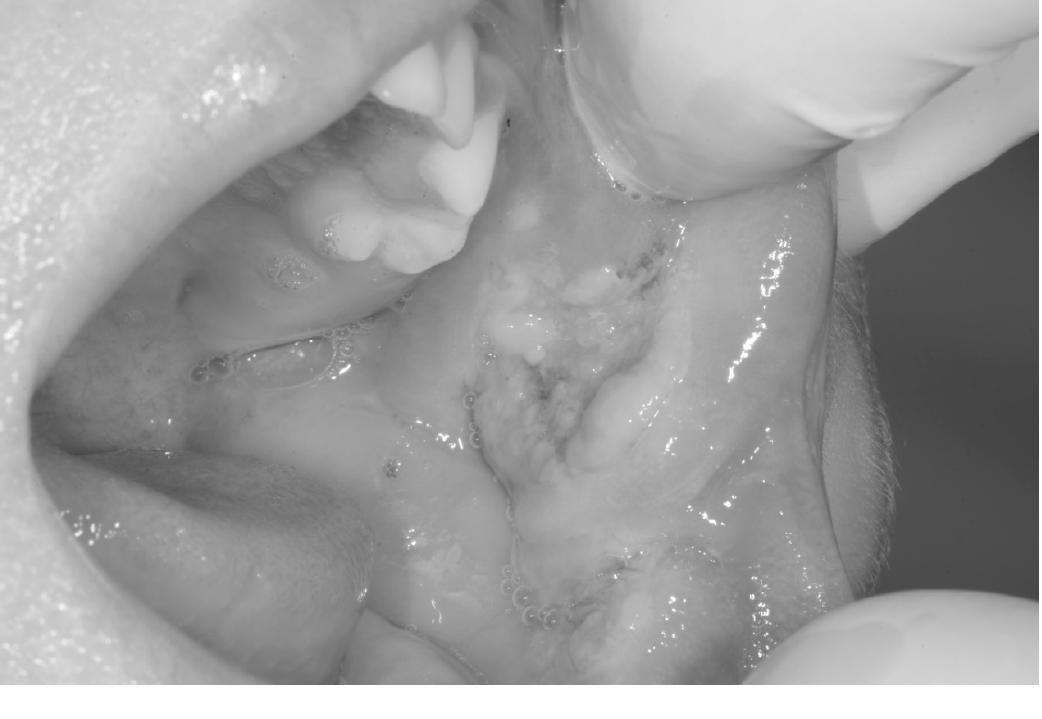
Figure 1. Bite injuries.